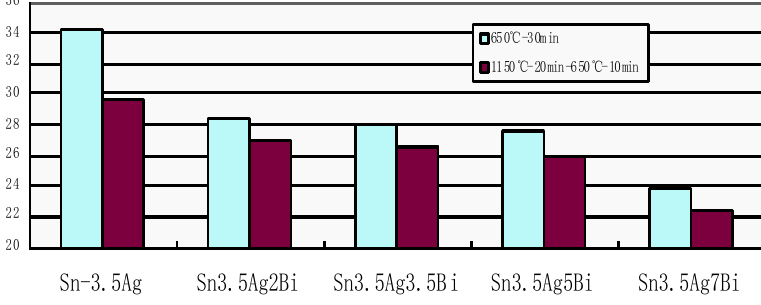
Figure 21. The effect of melt state on the wettability (wetting angle θ°) of Pb-free solder Sn-3.5Ag- x Bi/Cu joint [68].